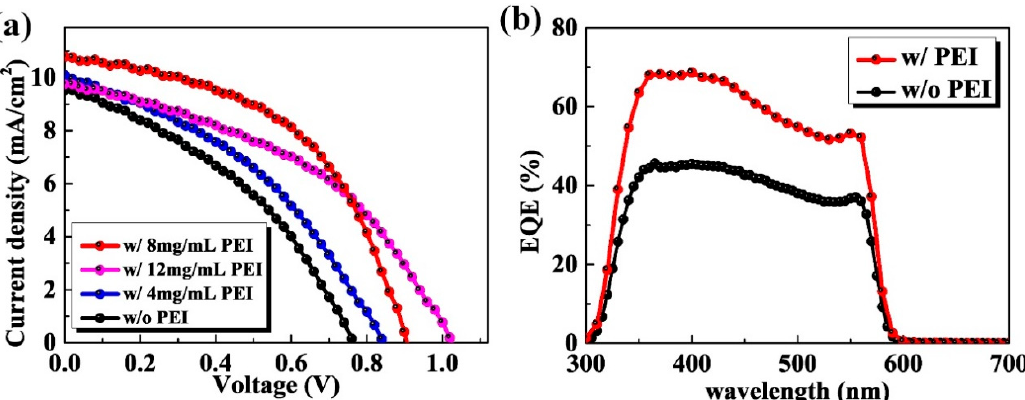
Figure 3. Photovoltaic characteristics of carbon-based, charge-transporting-layer-free, and all-inorganic CsPbIBr 2 PSCs. ( a ) J-V curves of CsPbIBr 2 PSCs without and with the varied-concentration PEI